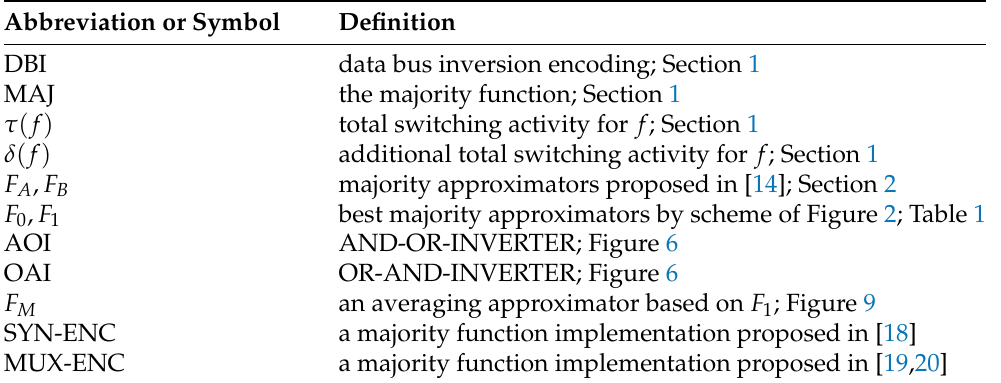
Table A1. List of Abbreviations and